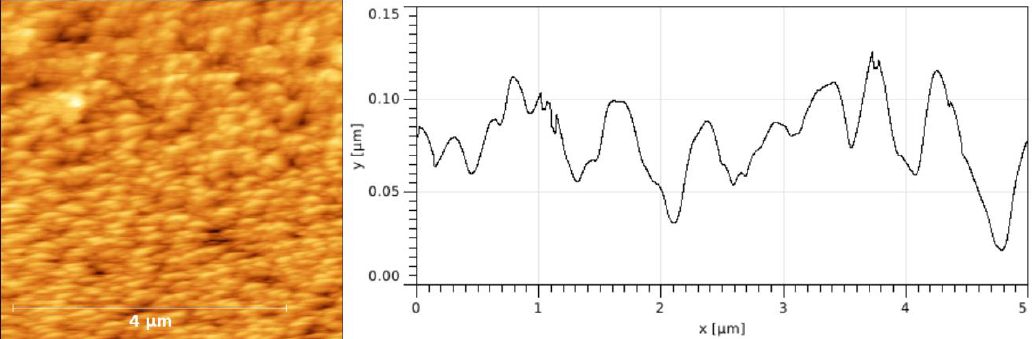
Figure 5: Atomic force microscopy data on one of the 6 LiF converter layers obtained by thermal evaporation. Left: AFM image, right: plot of the deposit profile.